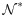
Sizes of the carrying capacity in both r/K strategies.The horizontal axis represents the ratio of the strength in the intraspecific competition (κ), and the vertical axis represents the size of the carrying capacity N*. The solid and the dashed lines represent the same entities as those in Fig 3, and the parameters used are also the same. Each vertical dashed line represents the boundary between the specialists and the generalists. This figure shows that the K-strategy always has greater carrying capacity than the other strategies, as demonstrated by Eq (32).